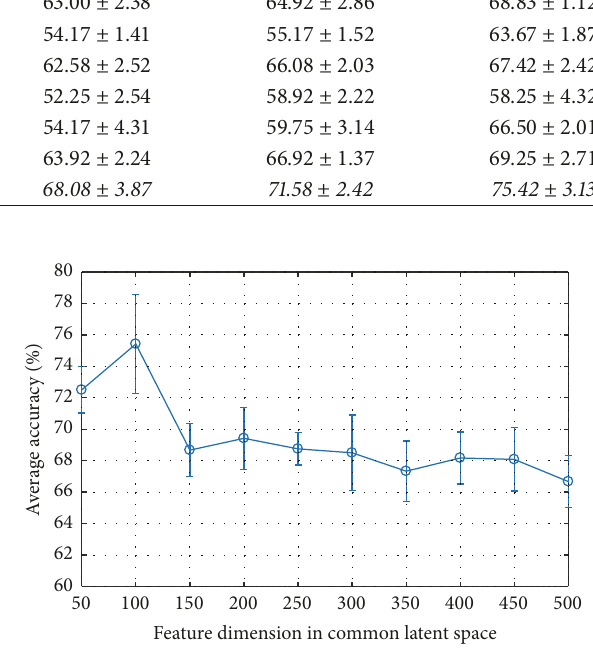
Figure 11: Feature dimension 𝑛 in latent space and classification accuracy